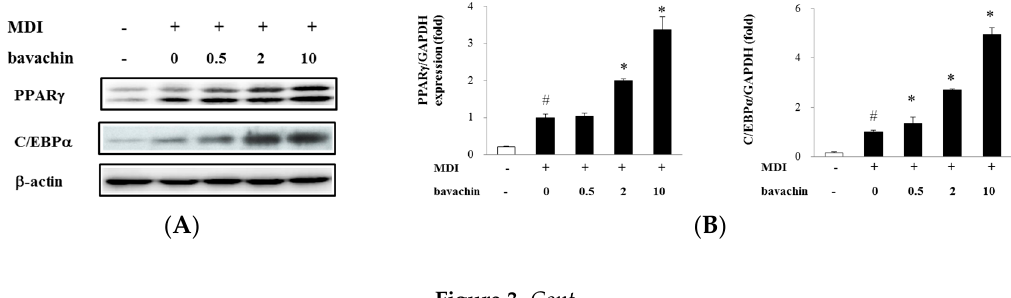
Figure 3. Cont. Figure 3.